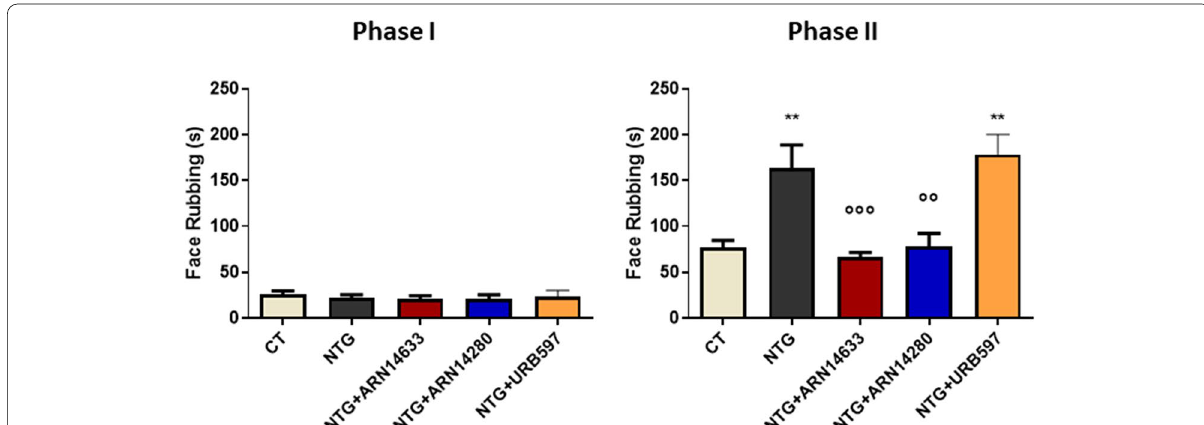
Fig. 2 Time spent in face rubbing behavior (seconds) during Phase I (0–3 minutes) and II (12–45 minutes) of the orofacial formalin test in rats treated with NTG vehicle (CT), NTG, NTG ARN14663 or ARN14280 or URB597 ( n 6–9 per group). Data are reported as mean SEM. One-way + = ± ANOVA followed by Tukey’s multiple comparisons test: ** p < 0.01 vs CT; °° p < 0.01 and °°° p < 0.001 vs NTG and NTG +